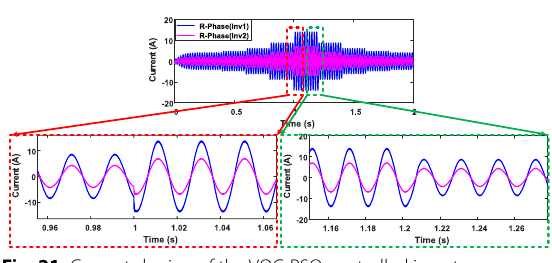
Fig. 21 Current sharing of the VOC-PSO controlled inverters (R-phase) with changing the load from 25 to 200%